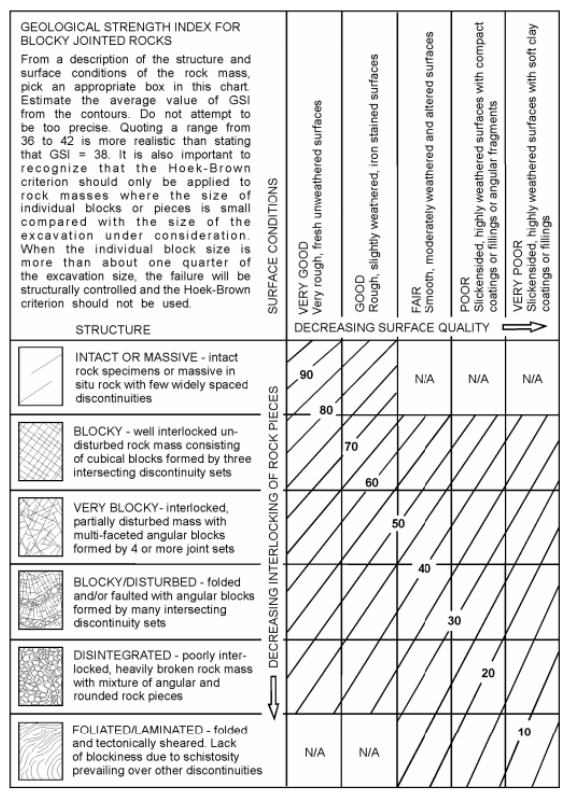
Figure A5. GSI chart for jointed rock masses [25].